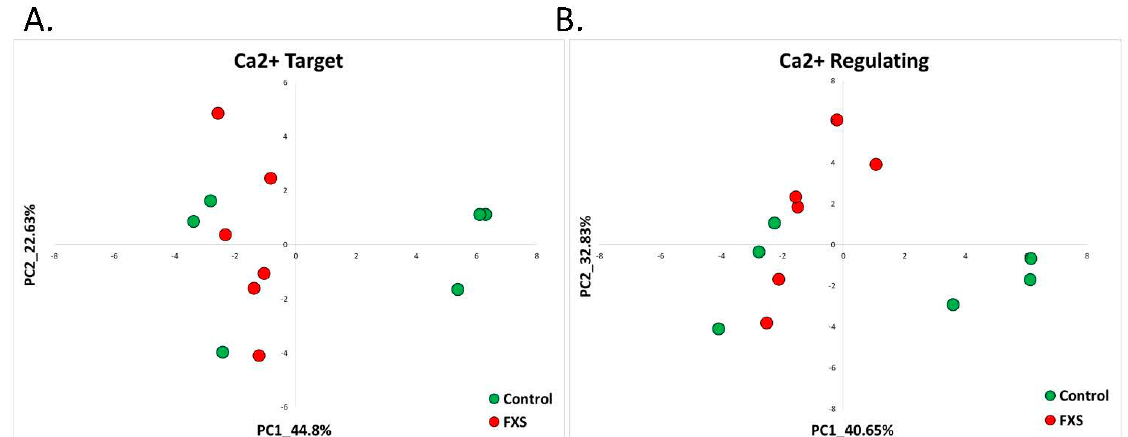
Figure 7. Fragile X Syndrome: calcium-target and calcium-regulating signatures. ( A ) PCA based on the expression of calcium-target signature genes in hiPSCs derived from FXS patients compared to control hiPSCs. The control samples are denoted in green, while the FXS samples are in red. ( B ) PCA based on the expression of calcium-regulating signature genes in hiPSCs derived from FXS patients compared to control hiPSCs. The control samples are denoted in green, while the FXS samples are in red.